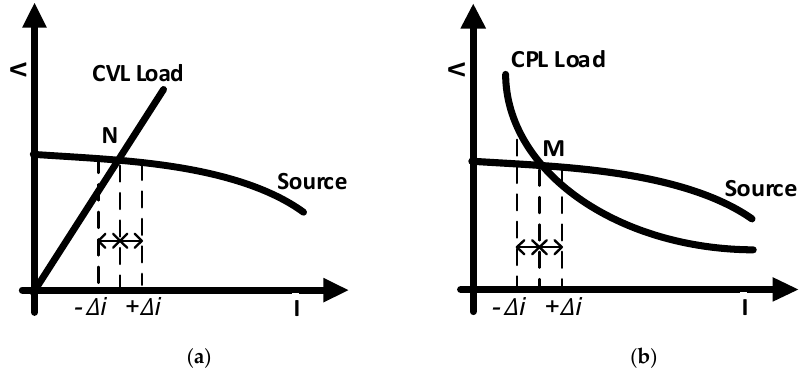
Figure 1. Typical V-I characteristics of ( a ) Constant Voltage Load (CVL); ( b ) Constant Power Load [3].